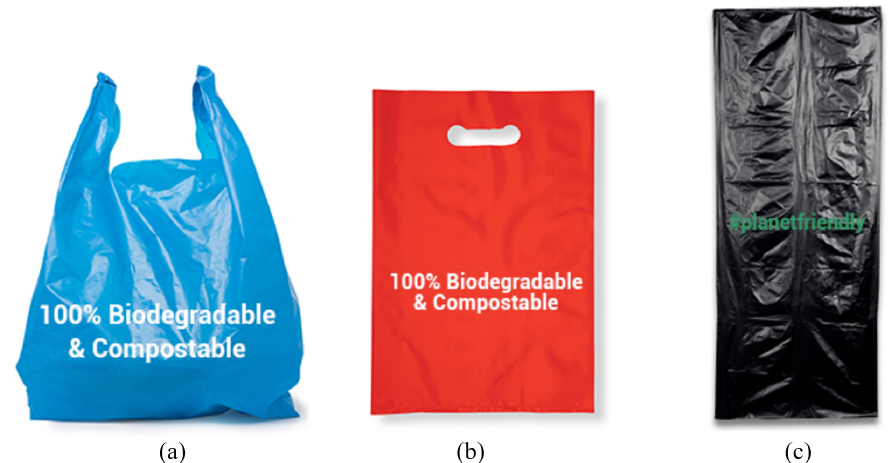
Figure 10. Cassava bags, ( a ) T ‐ shirt bag, ( b ) garbage bag, and ( c ) grip ‐ hole bag